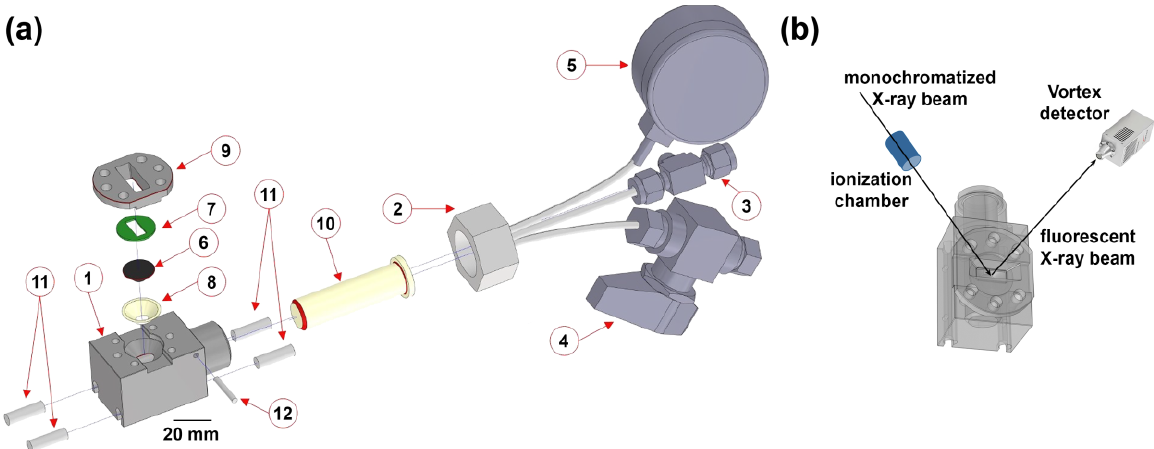
Figure 1. ( a ) Schematic view of the fluorescence cell. 1—cell body, 2—screw, 3—inlet fitting, 4—outlet valve, 5—pressure gauge, 6—glassy carbon X-ray transparent window, 7, 8—Teflon protecting rings, 9—flange, 10—Teflon reaction vessel, 11—heating elements, 12—thermocouple. ( b ) Sche ‐ matic view of the cell under operating conditions.